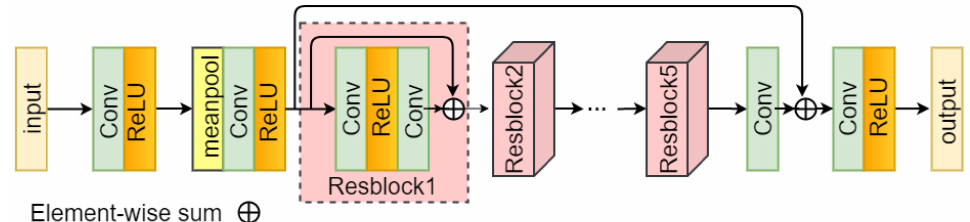
Figure 2. The down-sampling network of our closed-loop